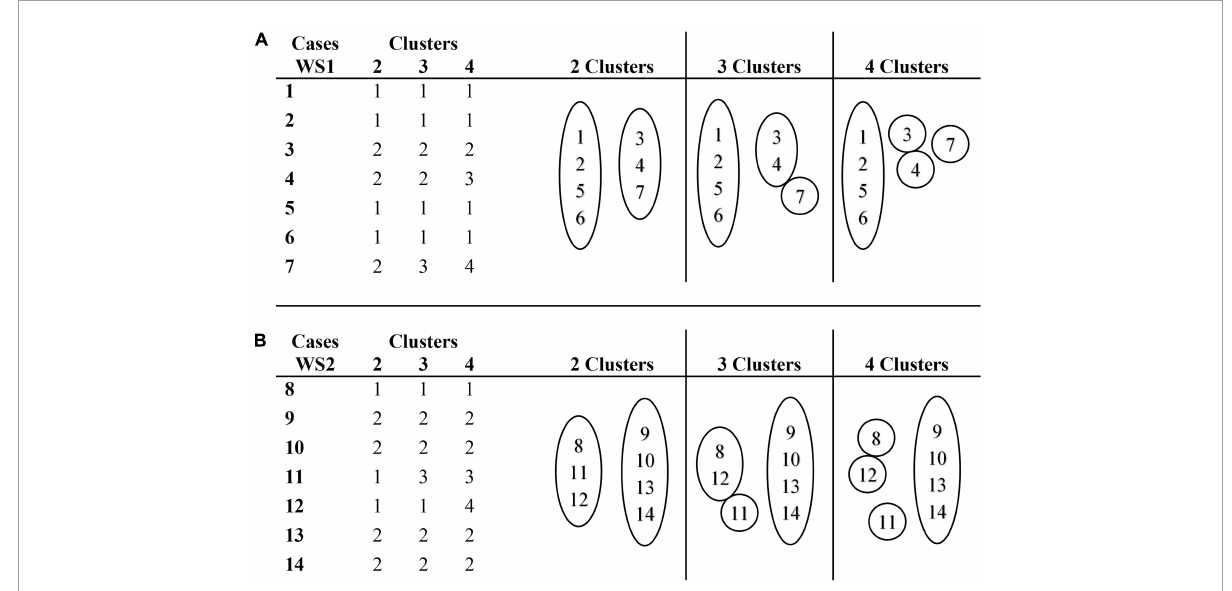
FIGURE5 Cluster membership for a range of solutions (2, 3, and 4 clusters) for classes of processes. (A) Cluster membership of cases in WS1 group. (B) Cluster membership of cases in WS2 group.